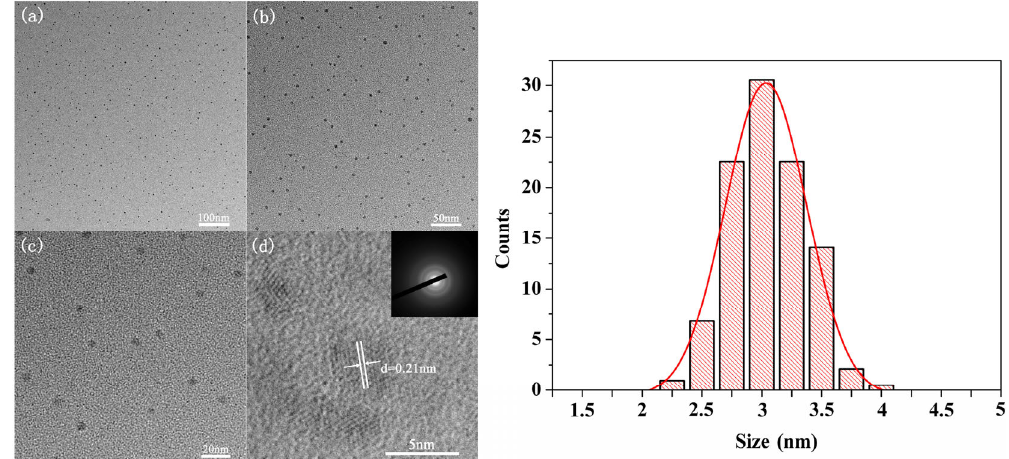
Fig. 2 HRTEM images, SAED pattern and size distribution of as-prepared water-soluble Cu nanoparticles.